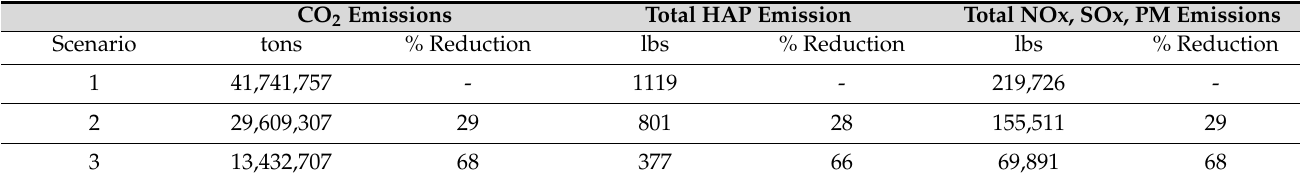
Figure 6. Contributors to the CO2 emissions; ( a ) Scenario 1, ( b ) Scenario 2 and ( c ) Scenario 3 . Table 4. Reduction in emissions via renewable energy integration in the remedial